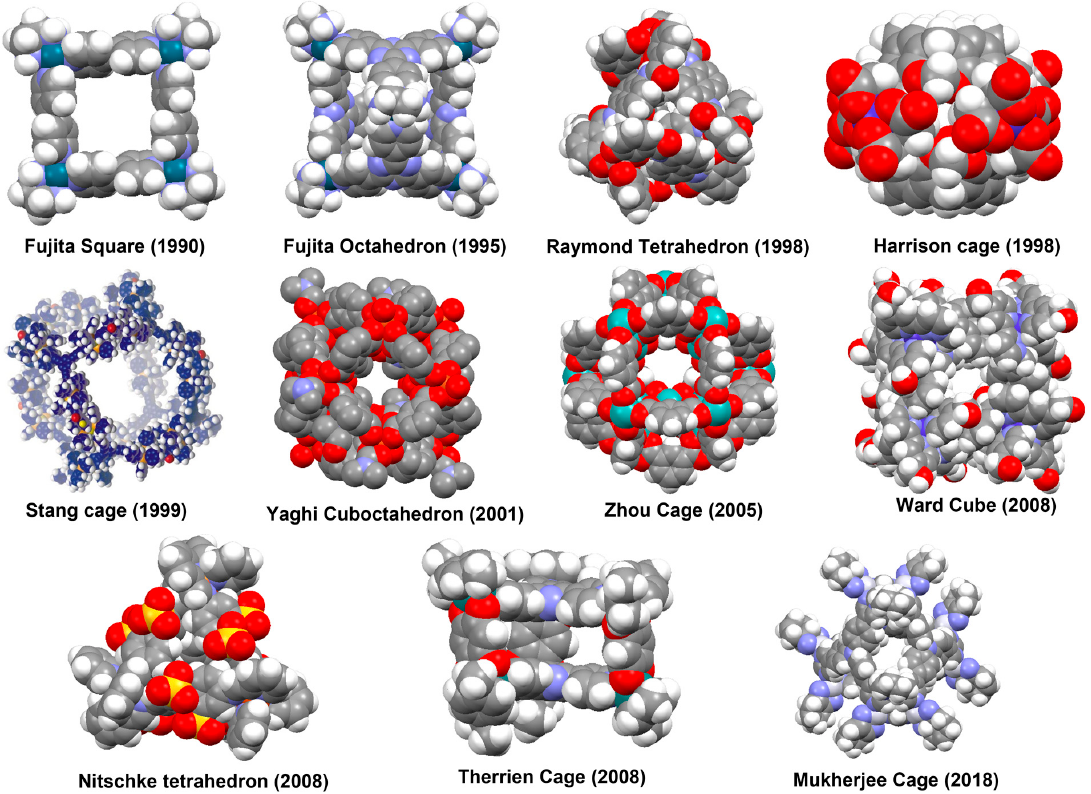
Figure 1. Representative examples of metal organic polygons and polyhedra (MOPs) that appeared in literature since early 1990s until recently, prepared using metal coordination chemistry from various donor-based ligands. In the parenthesis is reported the time when they appeared in literature. Pictures are reproduced by permissions from Refs. [22,27,37,58–65]. Copyright 1990, 1998, 2001, 2005, 2008, 2018 from American Chemical Society. Copyright 1995, 1999 from Nature Publishing Group. Copyright 1998, 2008 from Wiley-VCH.